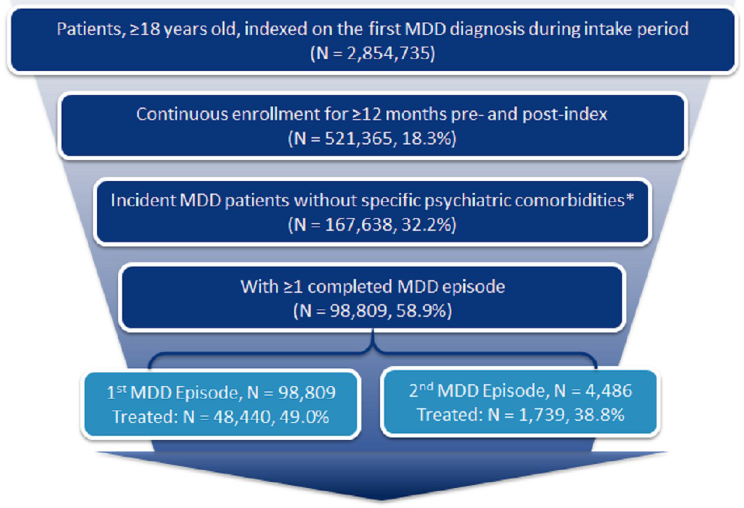
Fig 2. Attrition diagram. � Psychosis, schizophrenia, bipolar disorder, dementia and Tourette syndrome. MDD: major depressive